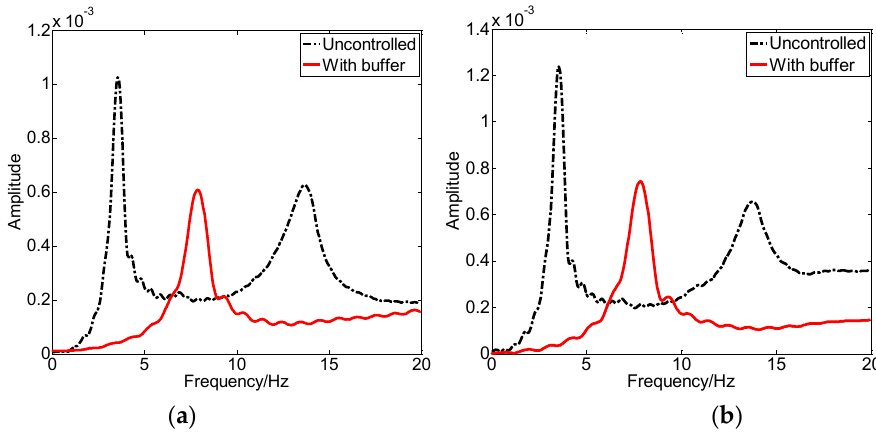
Figure 6. The frequency domain response: ( a ) Grade 4; ( b ) Grade 6.